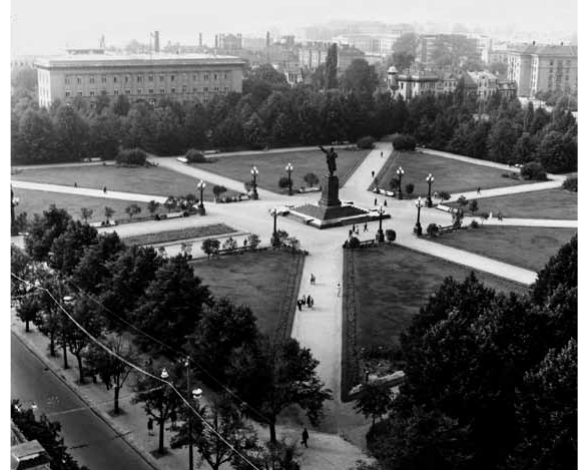
fig. 1. lenin (now lukiškės) Square in Vilnius 1972. a. Bra- zaitis photo. lithuanian Central State archive 1-20202